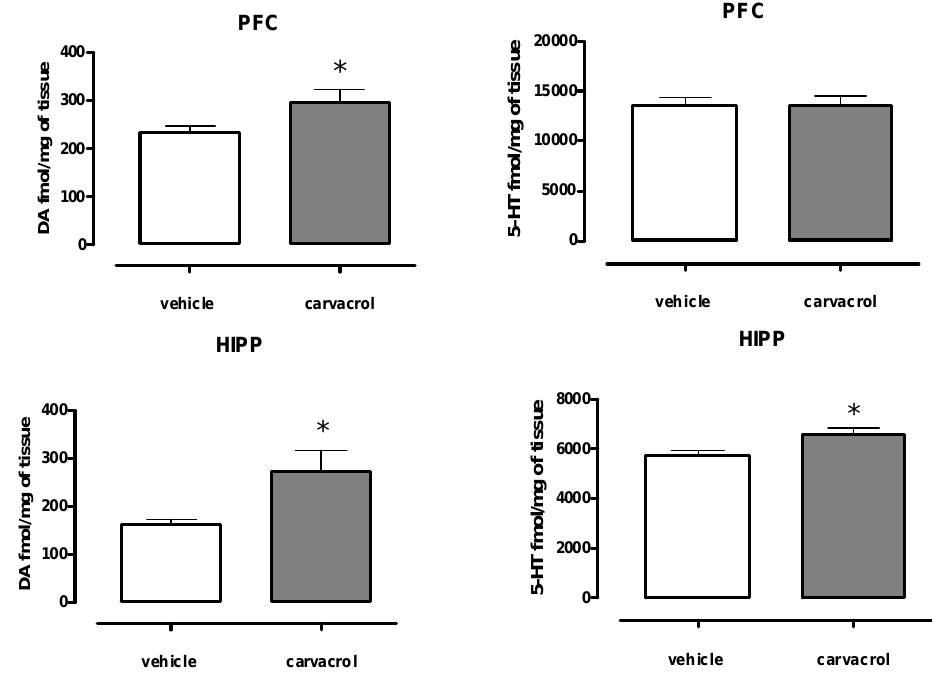
Figure 1. Measurement of DA and 5-HT content in PFC and HIPP of male Wistar rats, orally treated with carvacrol (7 consecutive days, 12.5 mg/kg) or vehicle (peanut oil, 1 mL/kg). Data were expressed as mean + S.E.M. ( n = 8, unpaired student’s t-test * P <